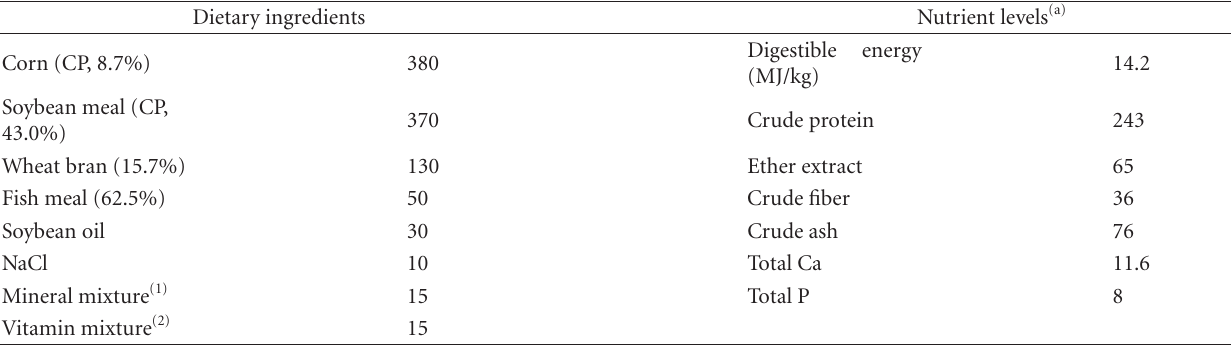
Table 1: Dietary ingredients and nutrient levels of the basal diet (g/kg, as-fed basis). Dietary ingredients